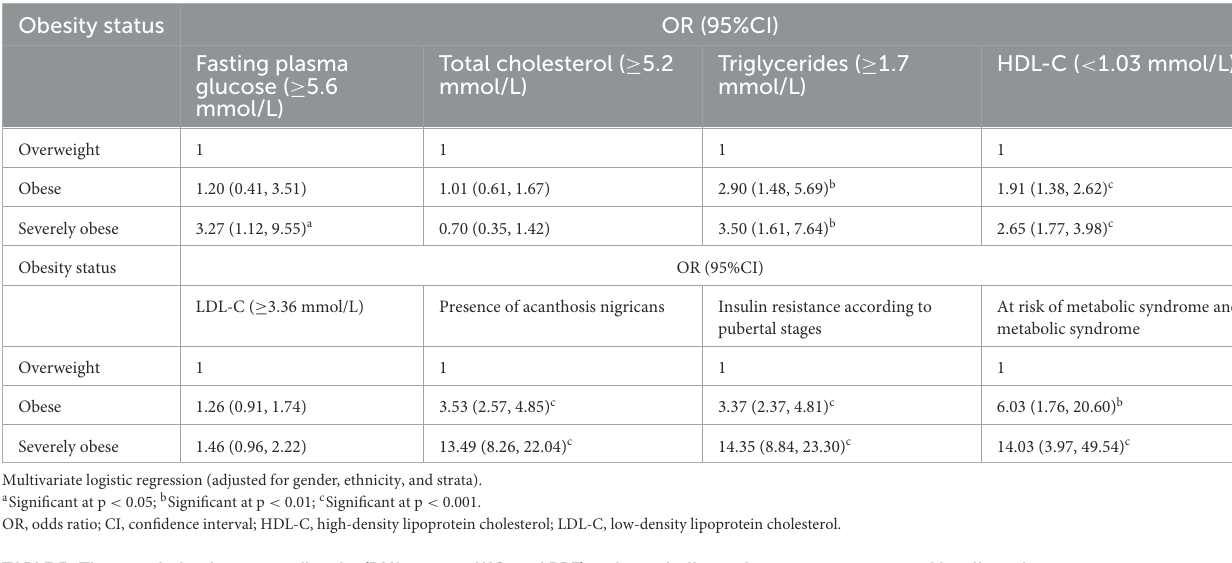
TABLE 5 The correlation between adiposity (BMI z-score, WC, and PBF) and metabolic syndrome components and insulin resistance. Metabolic syndrome